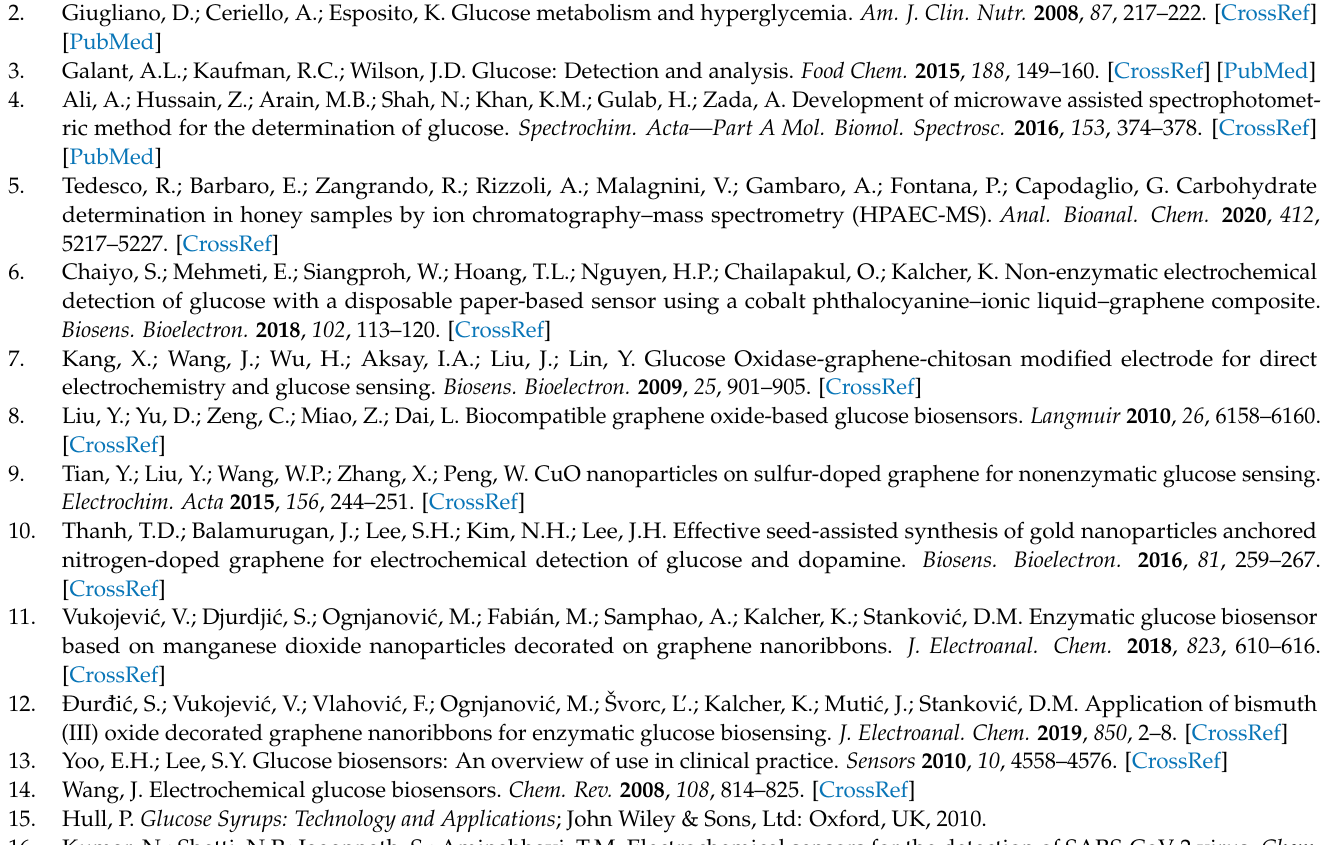
studies.; Figure S6: A visual representation of sensor current responses for chosen interferences.; Figure S7: Amperogram for one of the real matrix